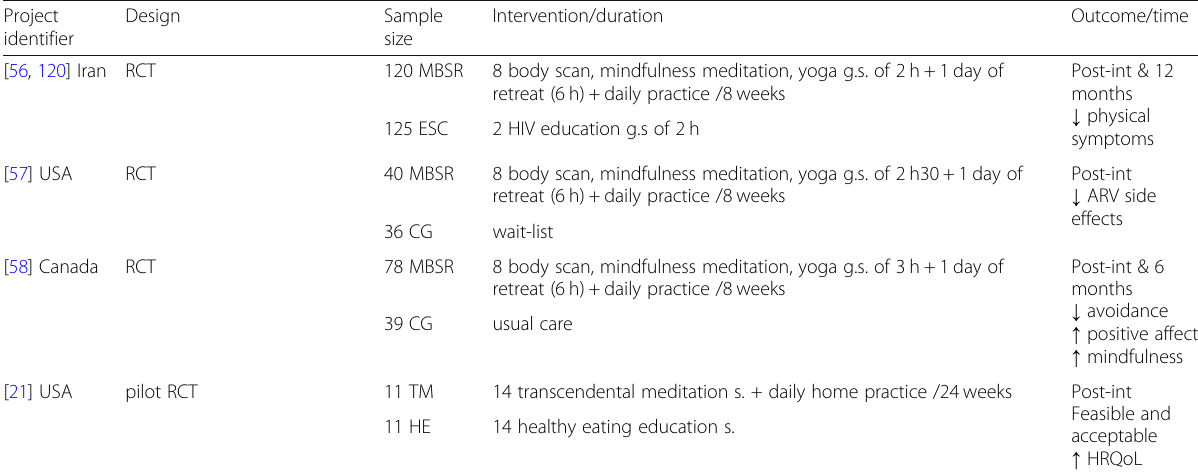
Table 5 Meditation included studies (Continued) Project